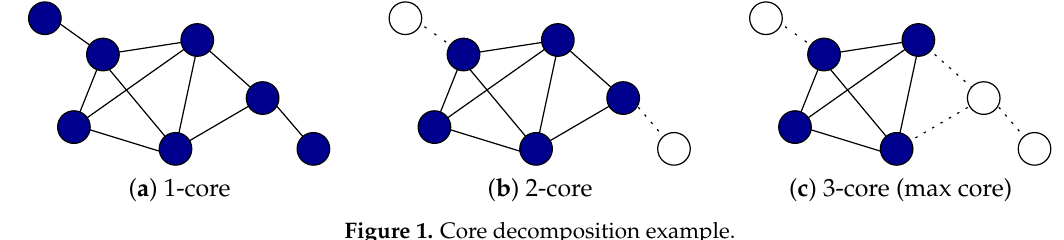
Figure 1. Core decomposition example. Algorithm 2: C ORE D ECOMPOSITION ( G ( V , E )